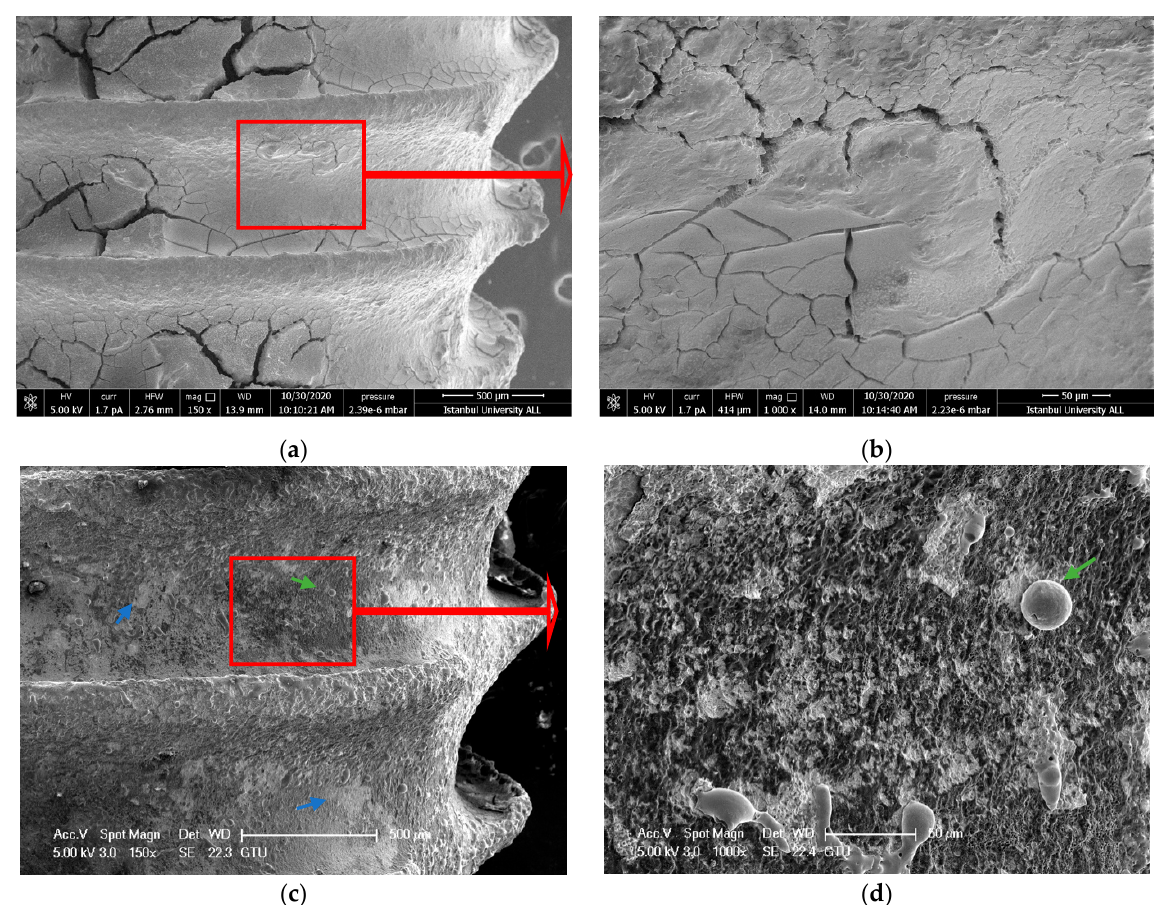
Figure 4. ( a , b ) SEM images showing the topography of untreated failed implant surfaces in ErL-SP group (150 × and 1000 × ) ( c , d ) after intervention (150 × and 1000 × ). The blue arrows indicate delamination and the green arrows indicate melting. Red arrows show the further magnification area.